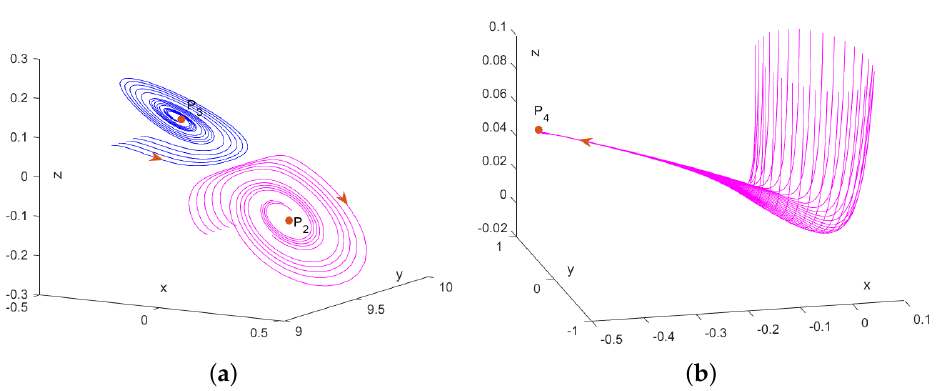
Figure 1. ( a ) Orbits around the attractors P 2 and P 3 in the system (3) projected in the xyz space. The parameters are a = 9, b = 0.1, c = 2, m = d = − 1. The starting points for P 2 are ( 0.2, 9 + i /2, − 0.1, 0.05 ) , while for P 3 they are ( − 0.2, 9 + i /2, 0.1, 0.05 ) , for i = 0,1,2,3,4. ( b ) Orbits around the attractor P 4 for a = b = 1, c = 10, m = 0.1 and d = −